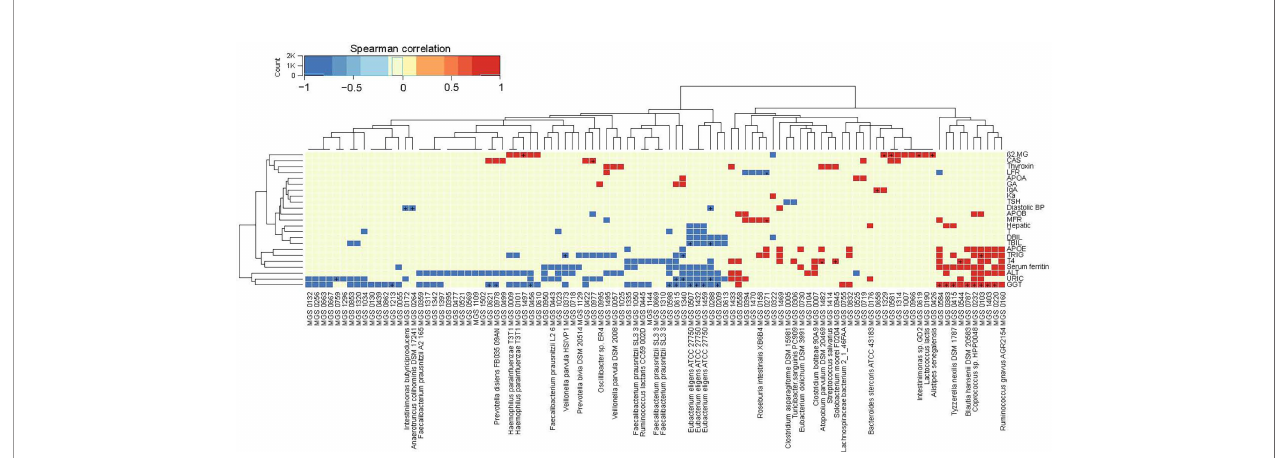
FIGURE 2 | Correlations between the gut microbiome and clinical parameters. Heatmap showing correlations between MGS and clinical parameters (Spearman correlation, p < 0.05). + q < 0.1; *q < 0.01. Color scale indicates the value of correlation coef fi cient.